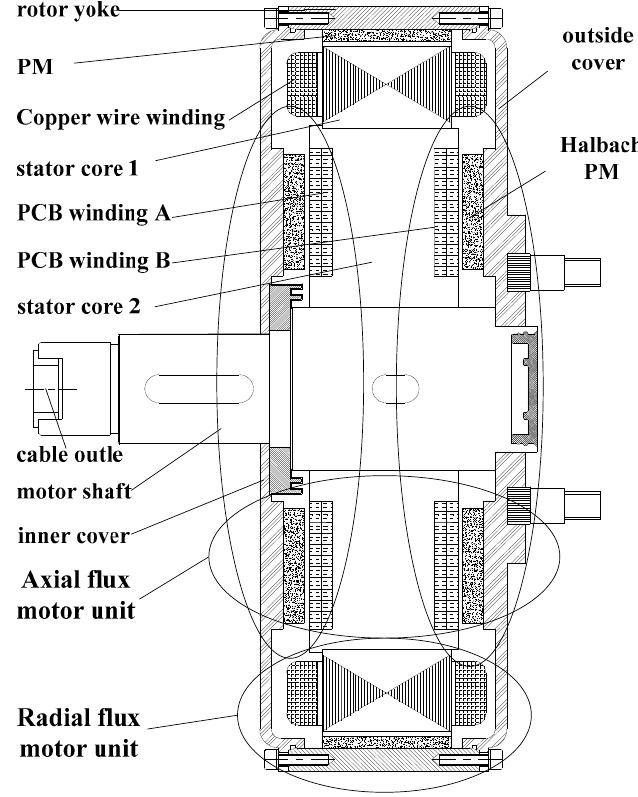
Figure 2. The dual-stator and dual-field-excitation permanent-magnet in-wheel motor (DDPMIM) structure. PM: permanent magnet; PCB: Printed Circuit Board.